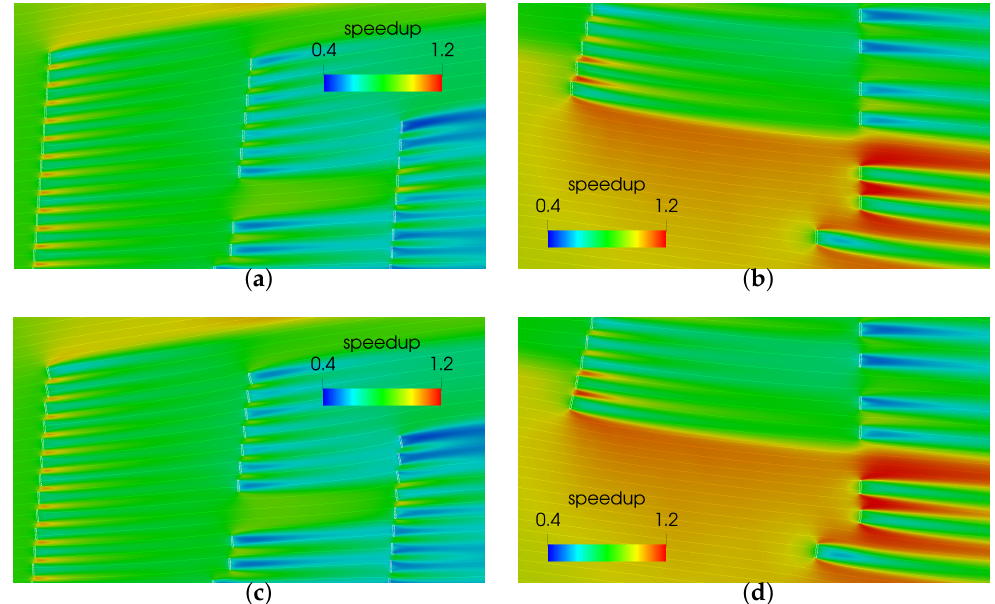
Figure 20. Closeup of the actuator disc realignment process on the Sisante wind farm (115 turbines) in the areas with higher realignment: ( a , b ) initial configuration and ( c , d ) final realigned configuration. The mesh is colored with respect to the wind speedup, and streamlines are also